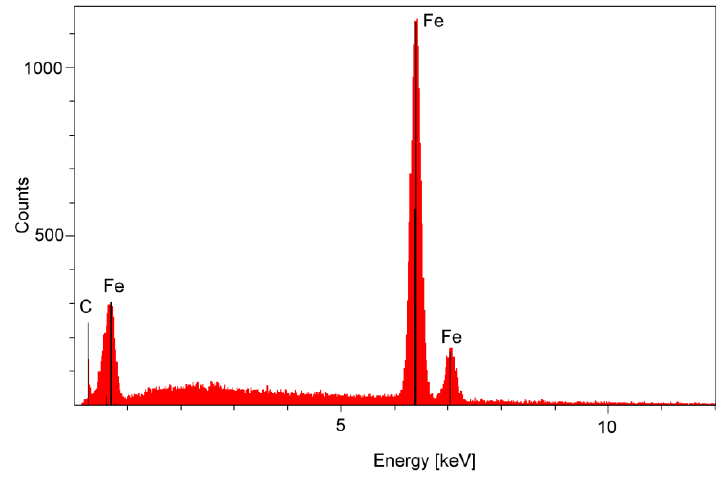
Figure 10. Energy dispersive spectrum in the micro-region of the AISI 1010 carbon steel surface after the experiment in sulfolane at 95 C without etching and subjected to the potentiodynamic test.